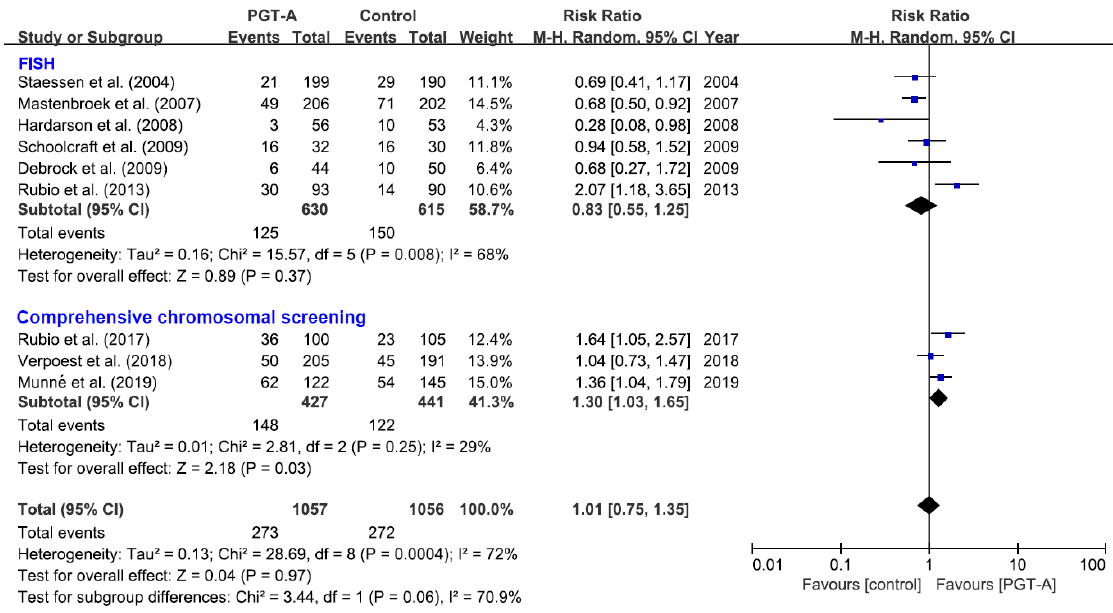
Figure 2. The effect of PGT-A with different techniques of genetic testing on live birth rate. Each study represented by a line. The square represents the point estimate of the effect for a single study, and its area is proportional to the weight of the study. The diamond represents the pooled effect estimate and the width of the dia-mond represents the 95% CI around this estimate.